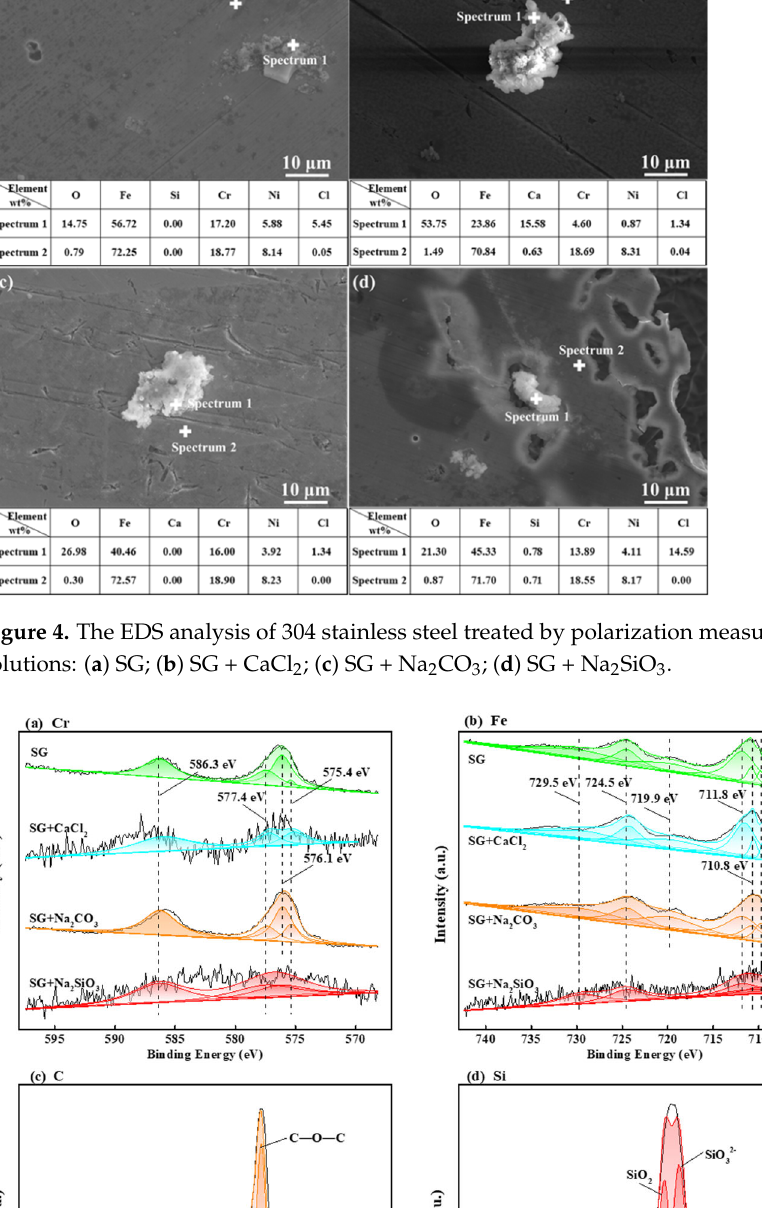
Figure 5. The XPS spectra of 304 stainless steel surfaces obtained after 4 week immersion in SG, SG + 20 mM CaCl 2 , SG + 20 mM Na 2 CO 3 , or SG + 20 mM Na 2 SiO 3 solutions at 40 °C: ( a ) Cr 2 p ; ( b ) Fe 2 p ; ( c ) C 1 s ; ( d ) Si 2 p .